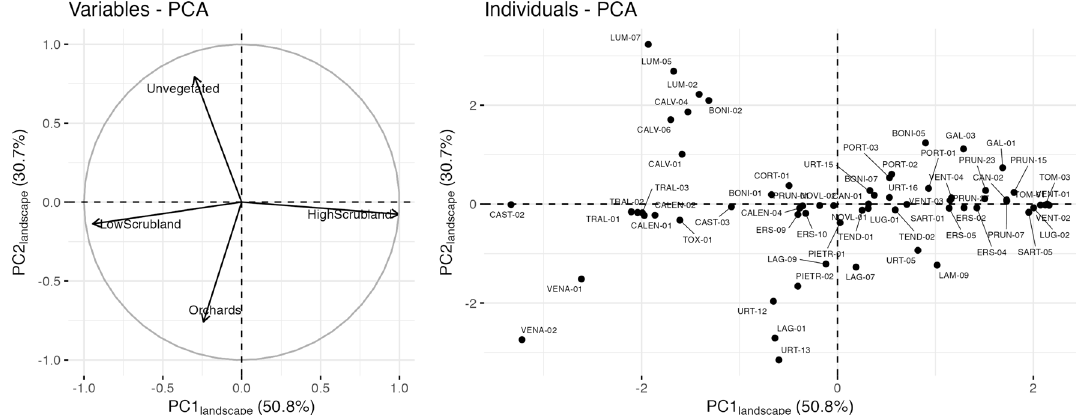
Figure 3. Principal component analysis of the proportion of each land cover type. ( A ) Correlation circle. ( B ) Projection of sampling plots in the first factorial plan.